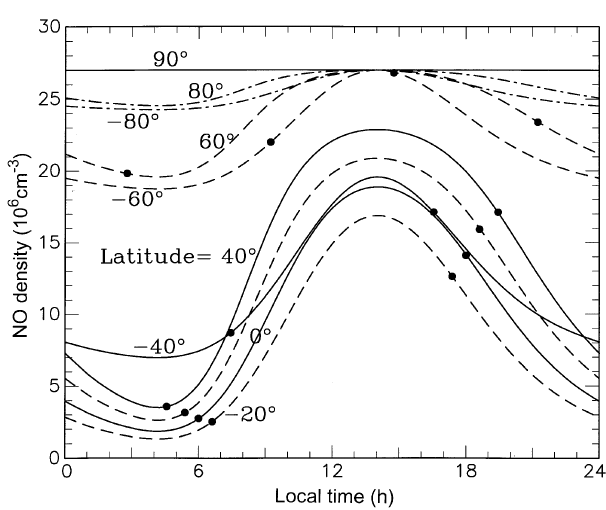
Fig. 3. Model values for the density at the peak of the NO layer, for June solstice conditions at F (cid:49)(cid:48)(cid:46)(cid:55) " 120 and A (cid:112) " 10. Solid dots mark the times of sunrise and